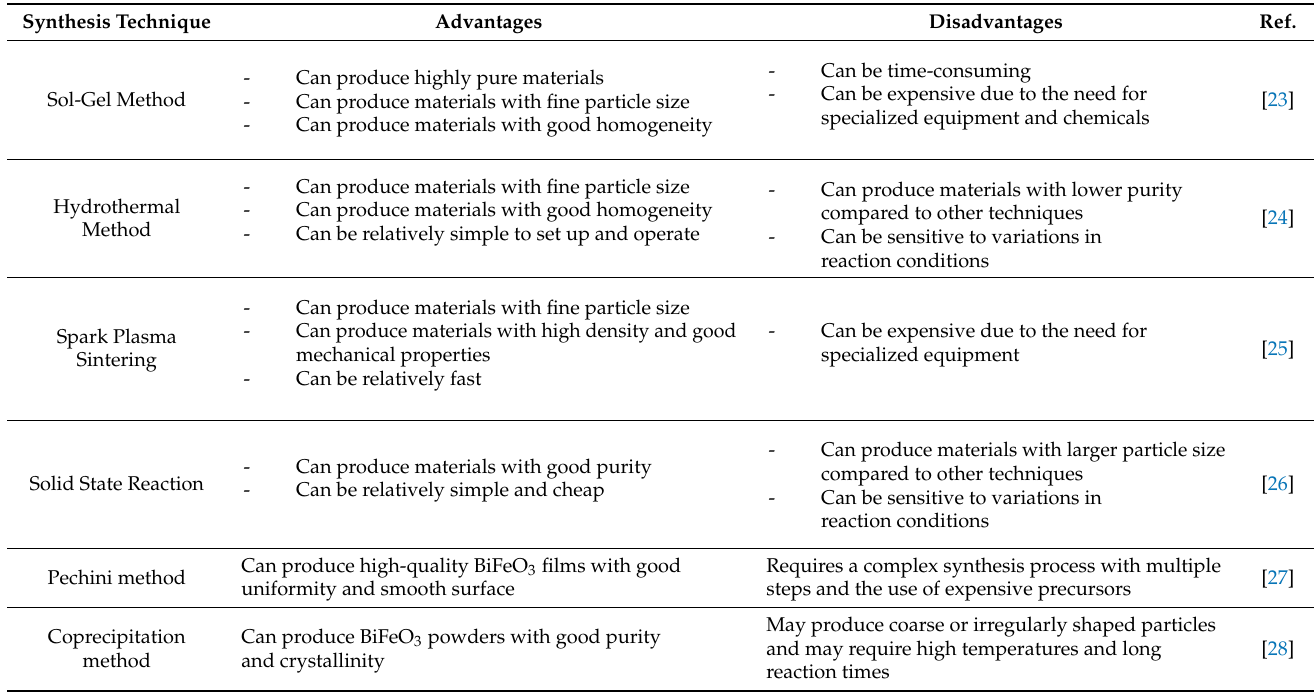
Table 1. Advantages and disadvantages of BiFeO 3 synthesis